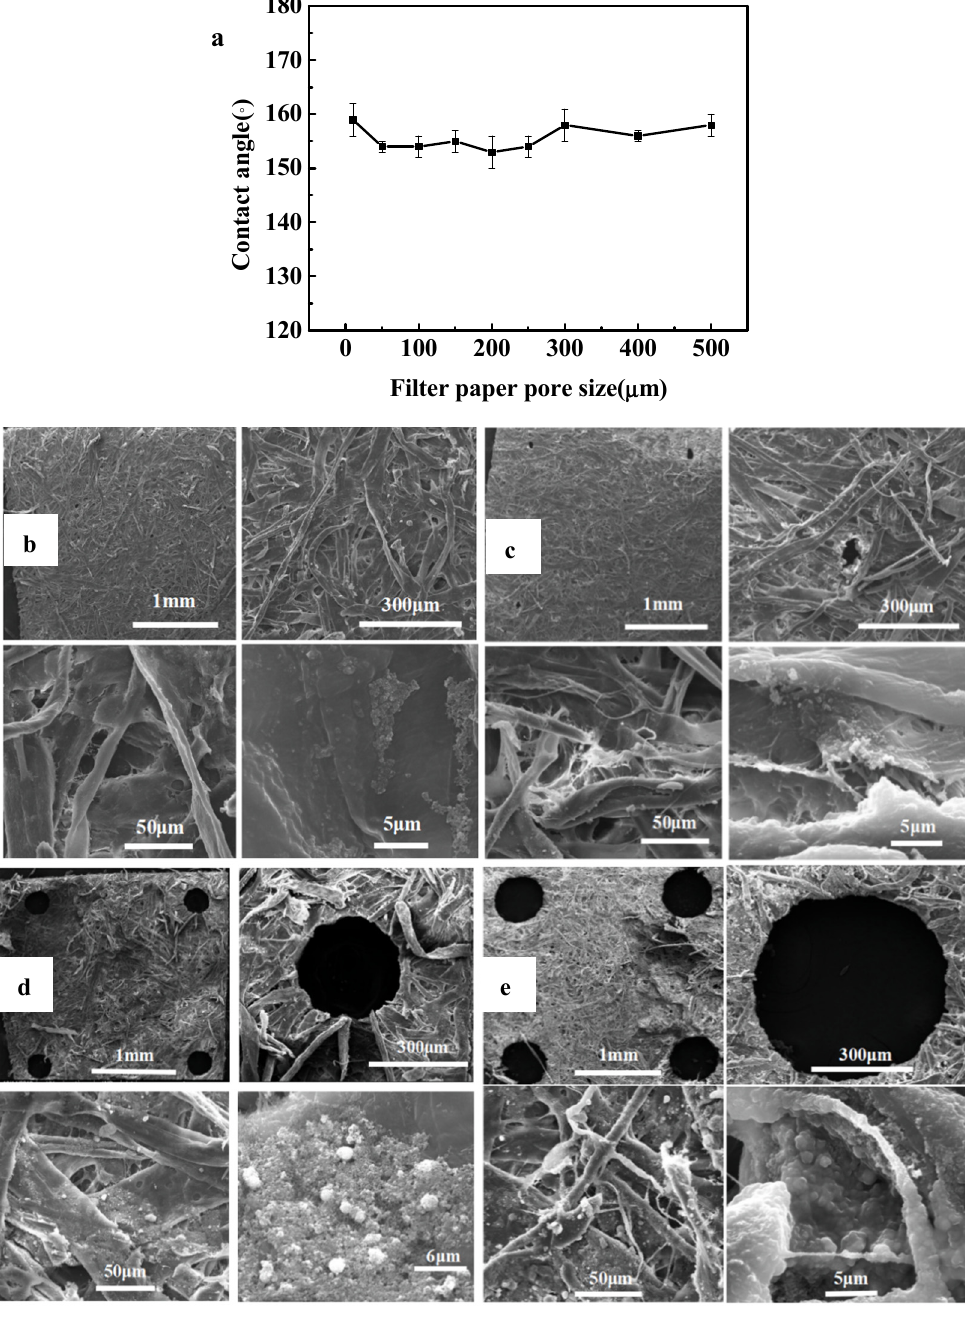
Figure 6. The surface wettability of the modified papers with different bored pore size in the range of 0–500 μ m ( a ); SEM of some typical bored papers with different bored pore sizes of 0 μ m ( b ), 50 μ m ( c ), 250 μ m ( d ), and 500 μ m ( e ), each paper modified by 0.3% TiO 2 nanoparticles was characterized with different magnification, respectively.